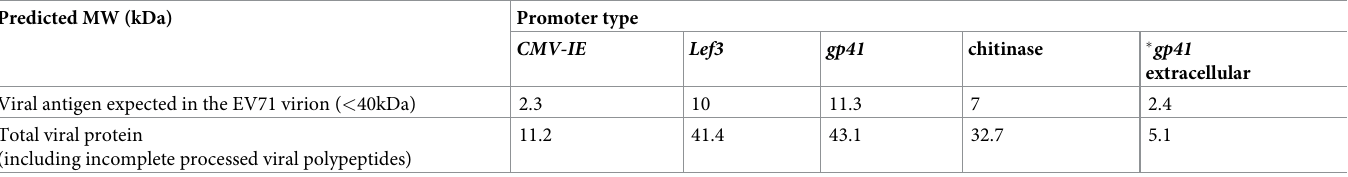
Table 1. Comparison of VLP yield according to promoter type (units: mg/L).